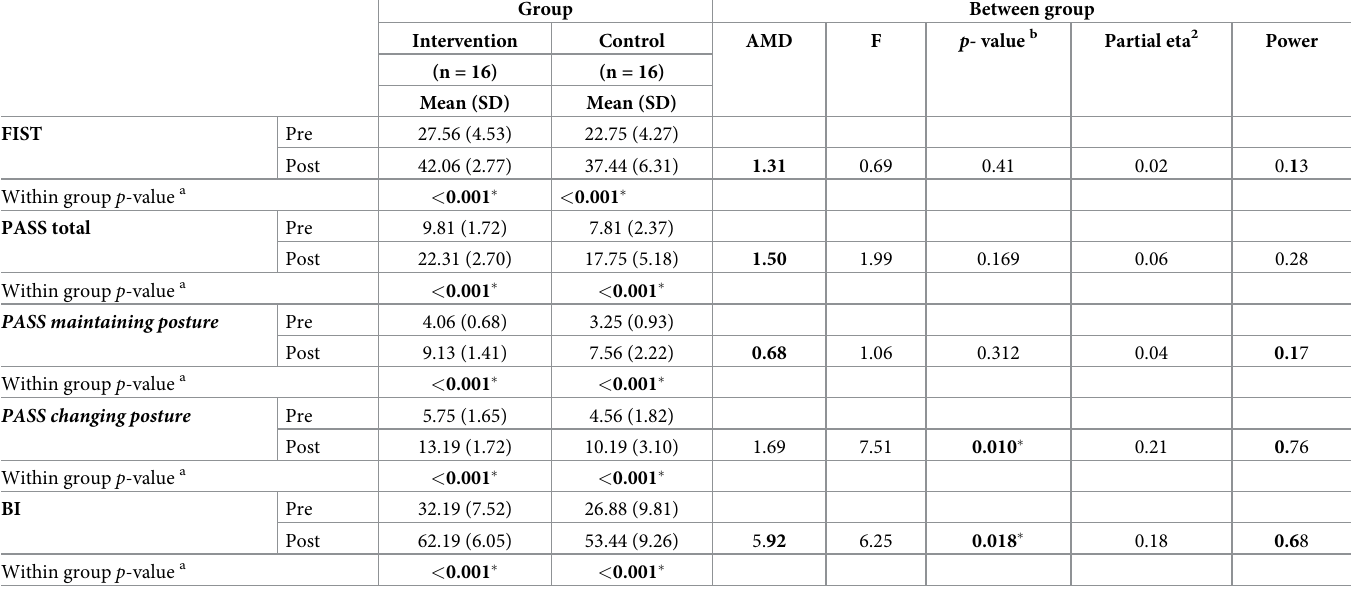
Table 2. Function in sitting test (FIST), postural assessment scale in stroke patients (PASS; total, maintaining posture, changing posture), and Barthel index (BI) at pre- and post-test of intervention and control